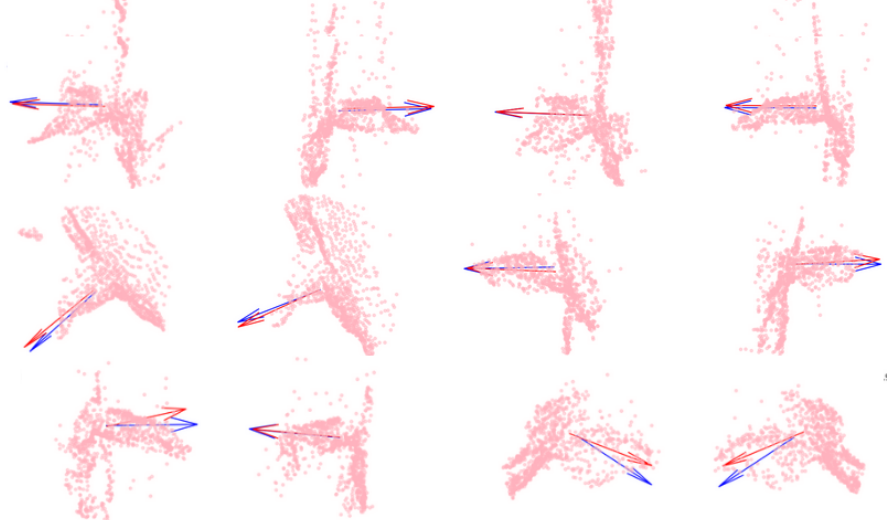
Figure 13. Test samples with arrows representing the demonstrated (blue) and predicted (red) cutting planes. (Top row) Samples with the smallest prediction error for (cid:126) nz . (Middle row) Samples with median prediction error for (cid:126) nz . (Bottom row) Samples with maximal prediction error for (cid:126) nz .